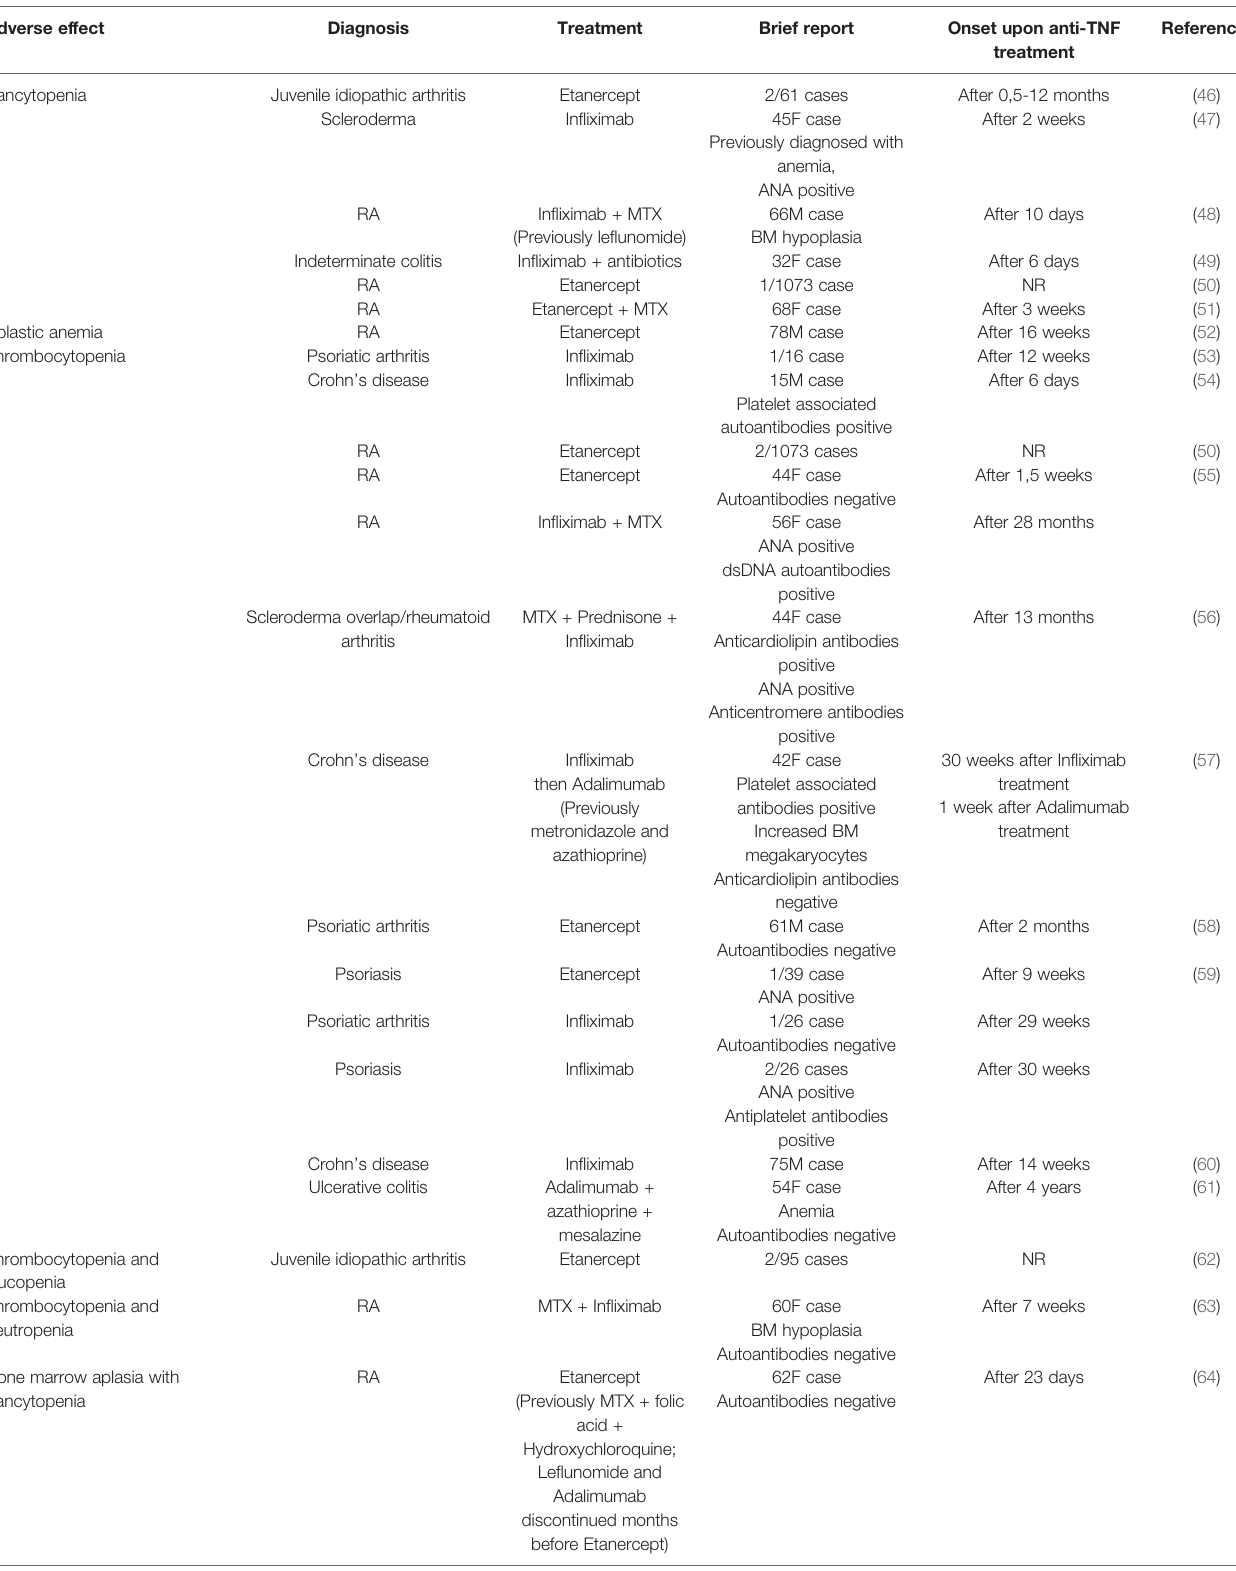
TABLE 1 | Hematological complications from systemic TNF